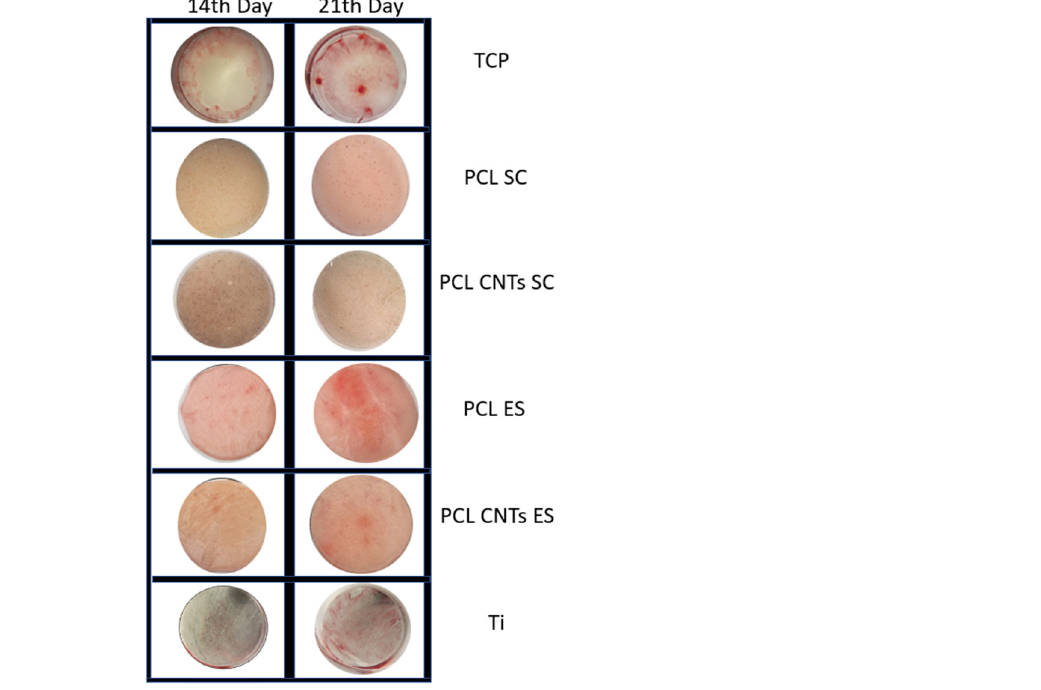
Figure 9. Quality alizarin red test on 14th day and 21st day for substrates with both high and low elasticity modulus.